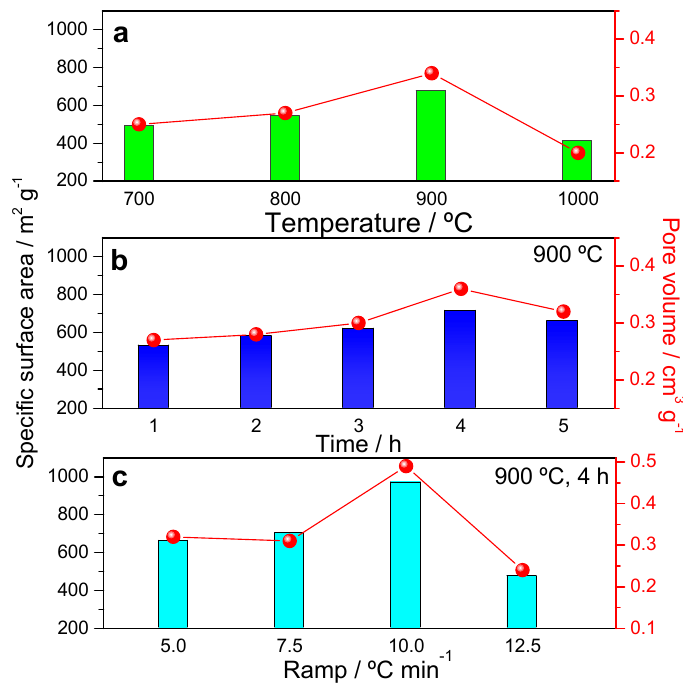
Figure 2. Effects of carbonization parameters on the textural properties of the almond shell-derived carbons: ( a ) temperature, ( b ) time, and ( c ) temperature ramp.